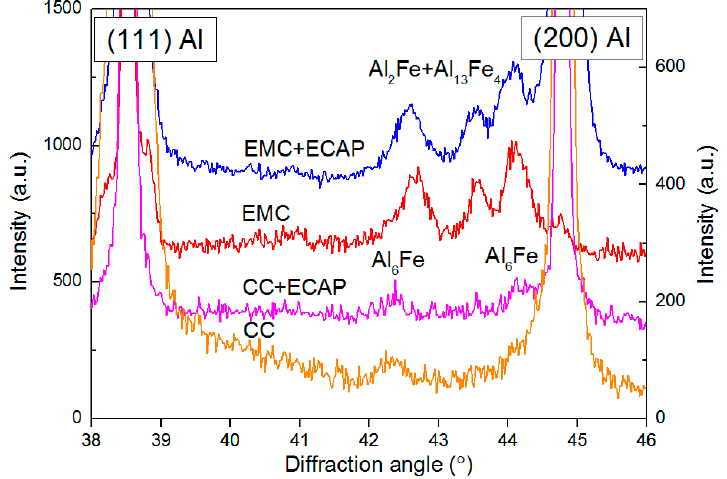
Figure 2. Elemental mapping of the microstructure of the CC ( a ) and EMC ( b ) alloys, SEM.